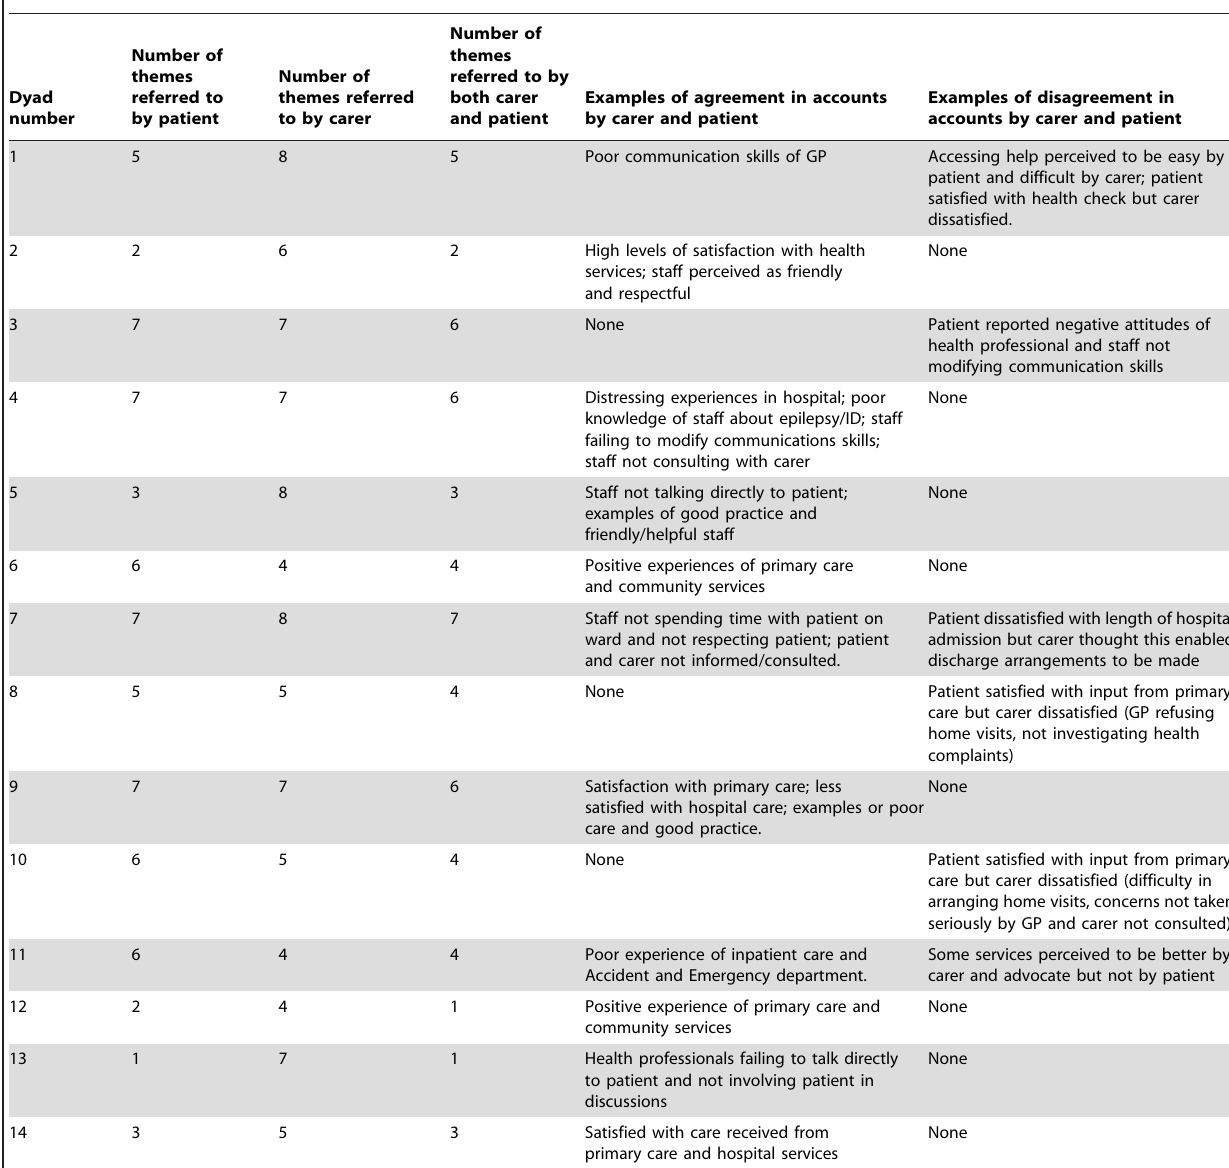
Table 4. Examples of agreement and disagreement in the accounts given by carers and patients within each